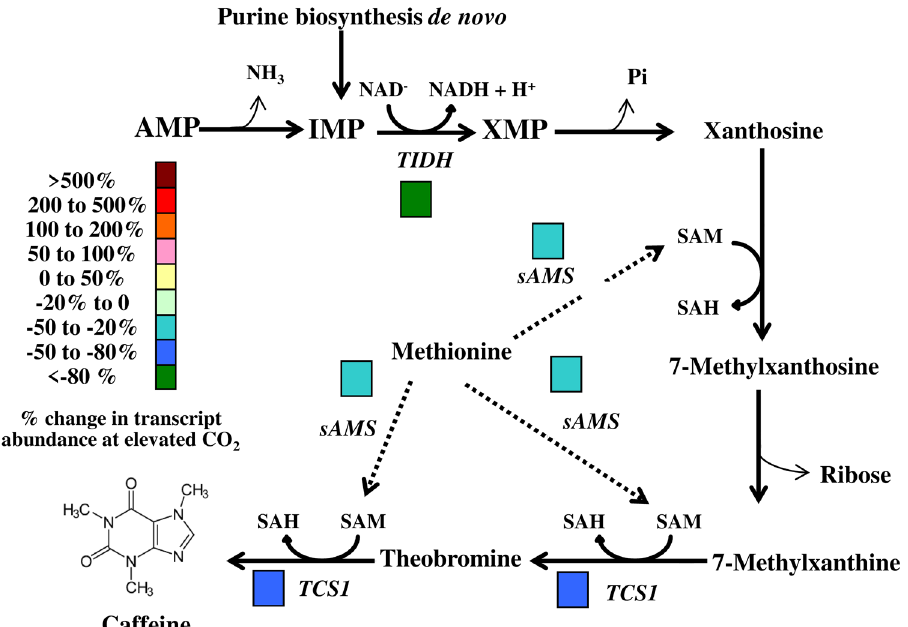
Figure 7. Transcriptional response of caffeine biosynthetic genes to elevated CO 2 in tea leaves. Tea seedlings were exposed to either ambient (380 µ mol mol − 1 ) or elevated CO 2 concentration (800 µ mol mol − 1 ) for 24 days. Expression levels of genes were analyzed by qPCR using gene-specific primer pairs (Supplementary Table S1). Four biological replicates were used for qPCR